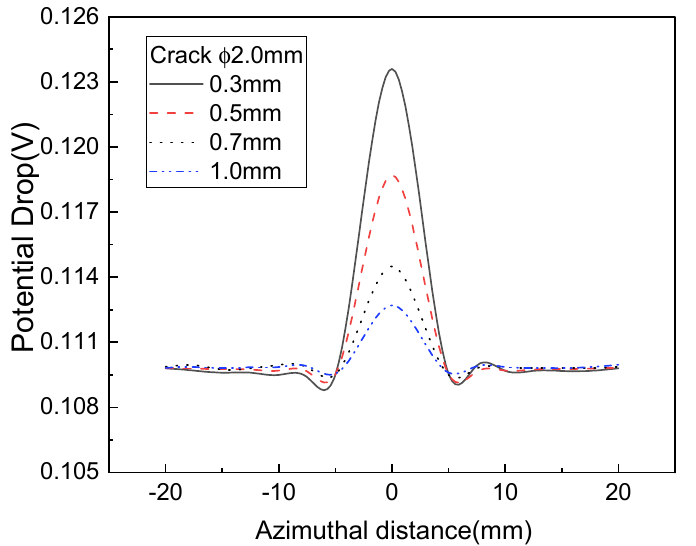
Figure 8. Variations of potential drop with different defect depths for a subsurface crack of 2.0 mm.